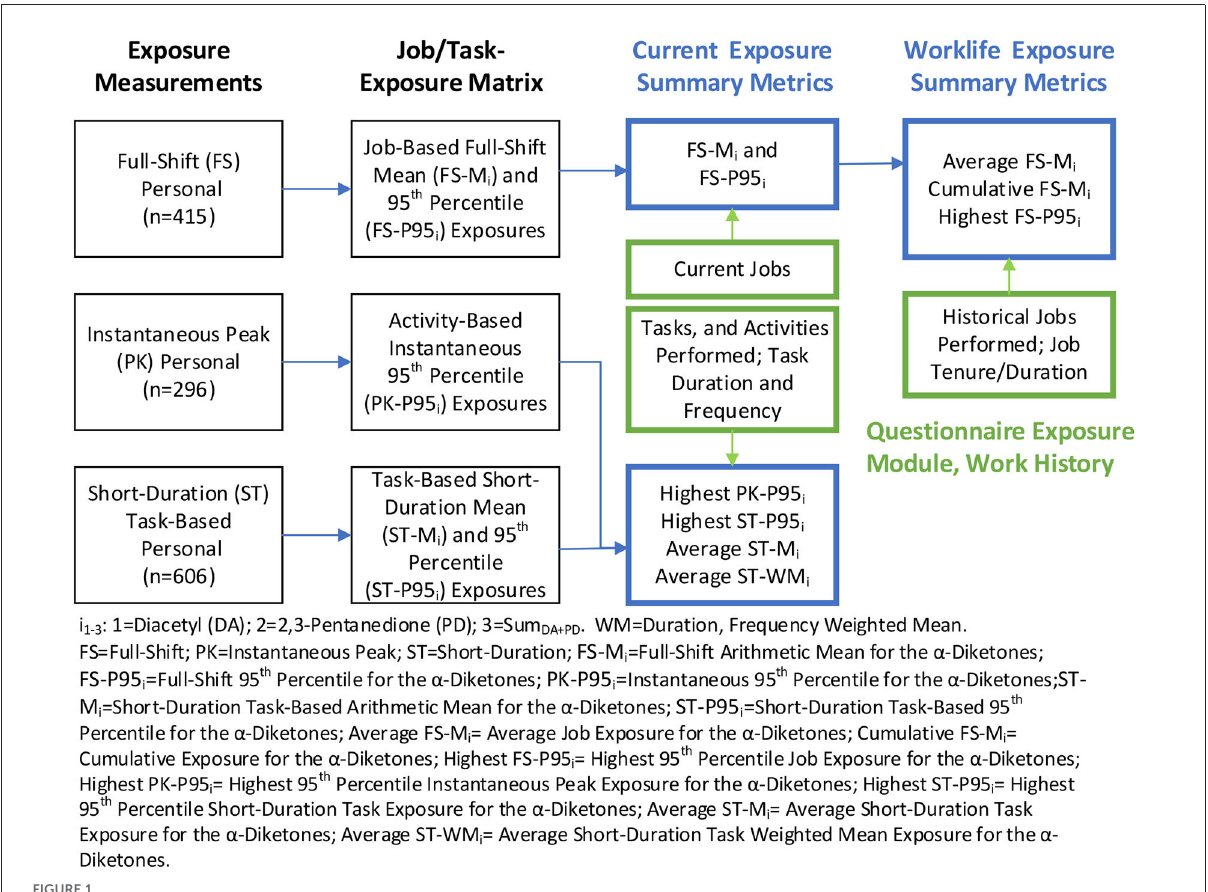
FIGURE1 Creation of job/task-exposure matrix and summary exposure metrics. Blue text boxes include metrics used in the epidemiologic analyses; green text boxes include information gathered from the questionnaire; black text boxes include exposure data and the summary metrics in the